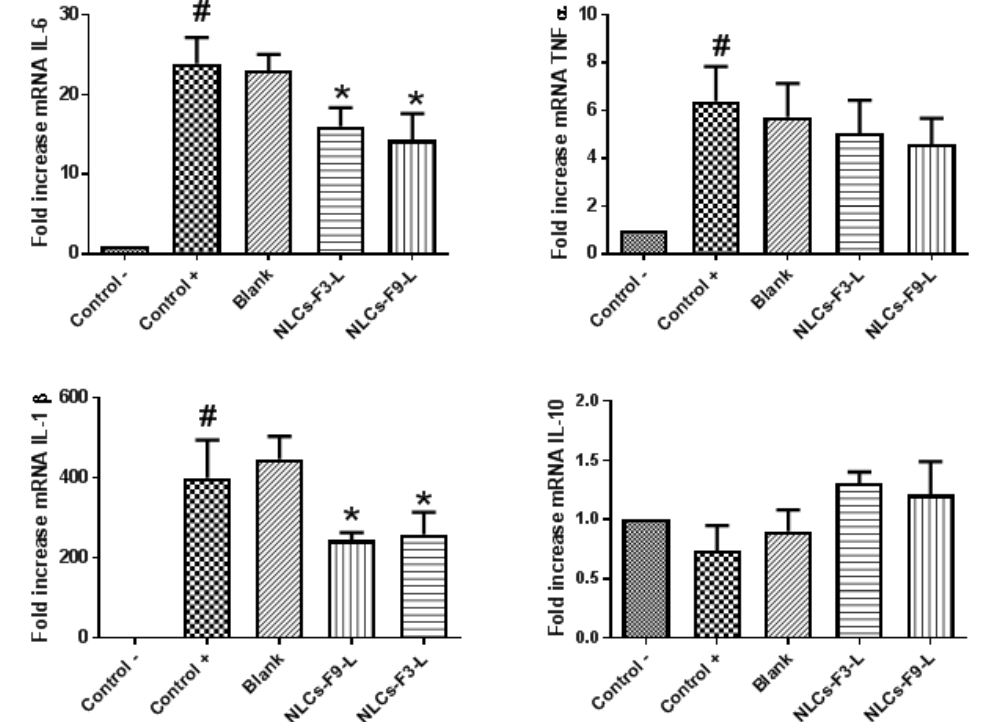
Figure 11. Relative mRNA level expression of inflammatory biomarkers IL-6, TNF- α , IL-1 β , and IL-10 in mice ear tissue after treatment with NLCs-F3-L and NLCs-F9-L. Differences between control − (non-treated skin) and control + (arachidonic treatment) is shown as #. Differences between control + and blank, NLCs-F3-L or NLCs-F3-L is shown as *. Results are shown as mean ± SEM of 3 independent experiments ( p < 0.05).